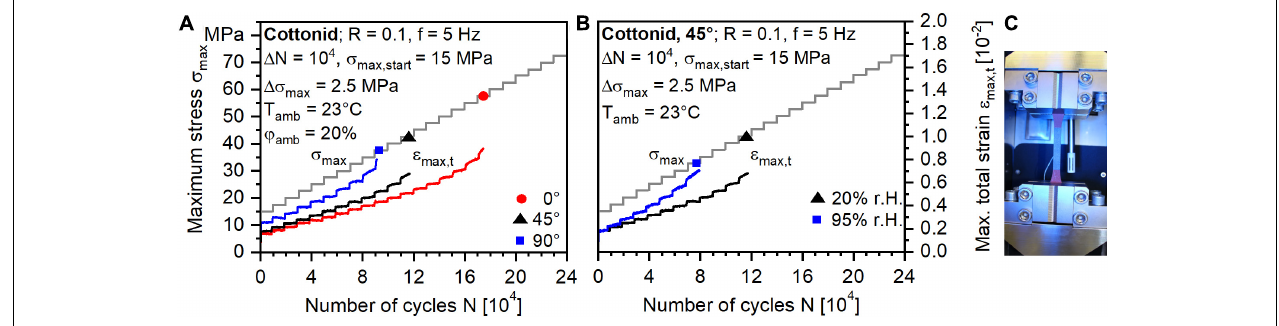
FIGURE 6 | Results of multiple step test (MST): (A) Direction-dependent and (B) Humidity-dependent fatigue properties of Cottonid, (C) Mounted and instrumented fatigue